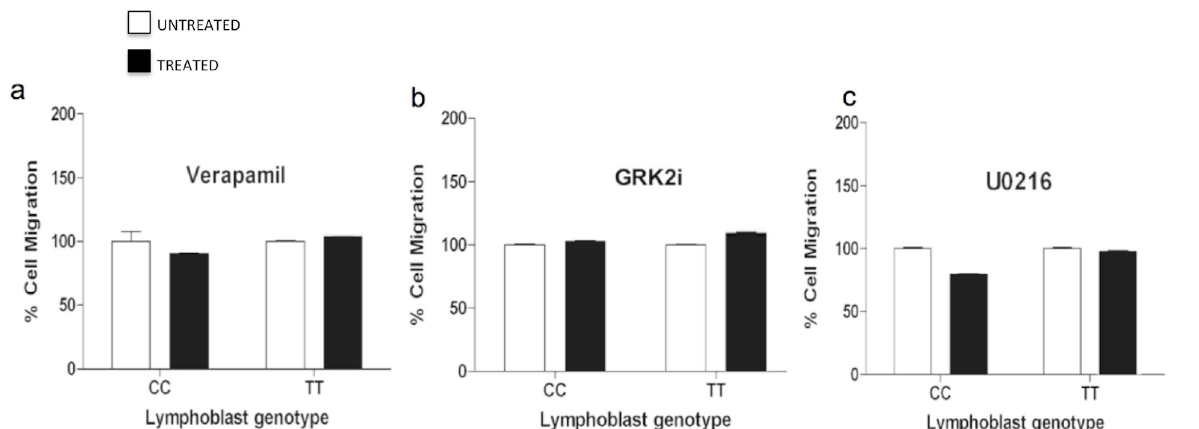
Figure 12. Gβ3s-induced enhance cell migration is blocked by ERK or Ca 2+ ion channel inhibition confirming that Gβ3s associated migration is a Ca 2+ regulated phenomenon. Boyden chamber assay on serum starved CC and TT lymphoblast cells was performed to study the effect of G bg signaling inhibitors on EGF stimulated chemotactic migration. Control is represented as 100% migration and refers to 5% BSA stimulation in both CC and TT lymphoblast cells. While ERK and Ca 2+ ion channel inhibition caused complete disruption of EGF-stimulated enhanced migration of TT cells, GRK2i inhibition only caused partial inhibition of growth factor induced migration. Data presented in all panels are the mean with standard error (bars) of n = 3 independent experiments performed in octuplets. Statistical significance is shown as *P<0.05, **P<0.01,